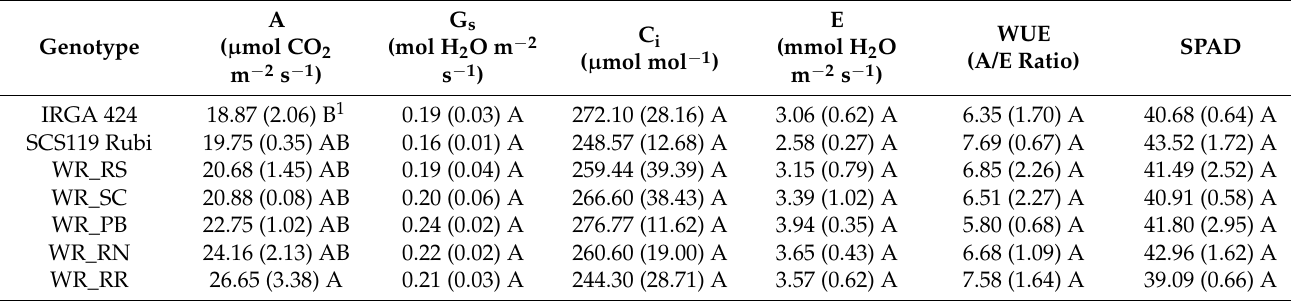
Table 3. Means of photosynthetic rate (A), stomatal conductance (G s ), intercellular CO 2 concentration (C i ), transpiration rate (E), water use efficiency (WUE), and chlorophyll meter index (SPAD) in rice and weedy rice under controlled conditions. Values within parentheses represent a 95% confidence interval.